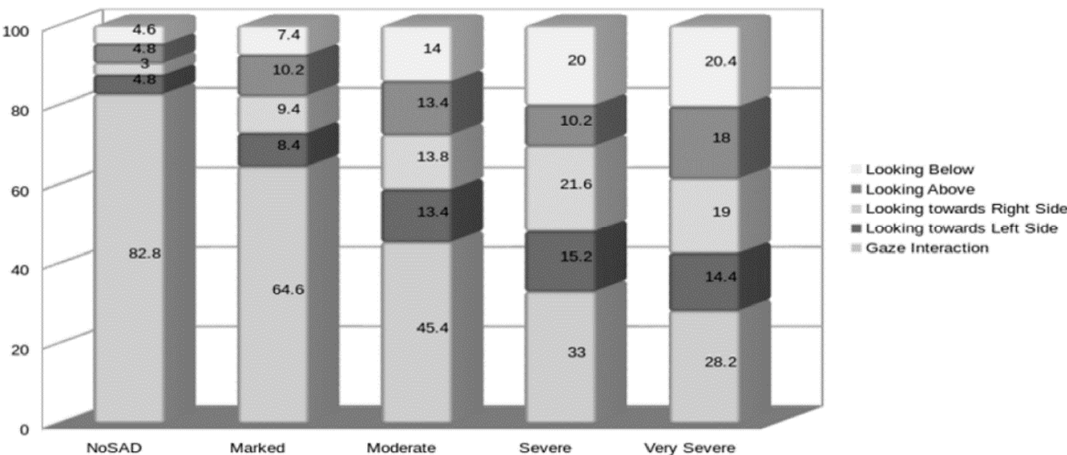
Figure 9. Comparison between gaze avoidance behavior of males.